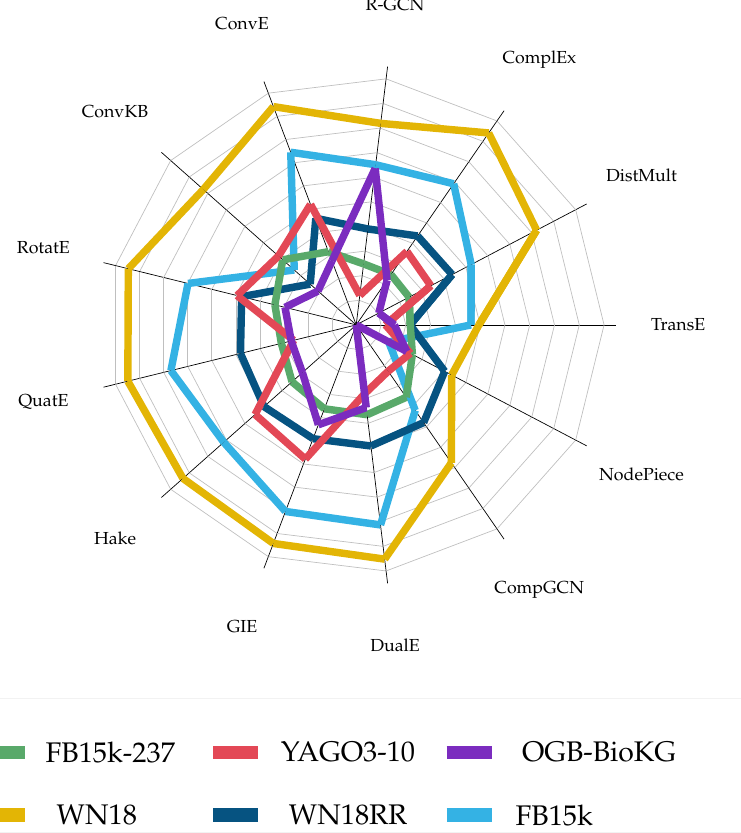
Figure 8. Performance of models on all datasets using MRR.